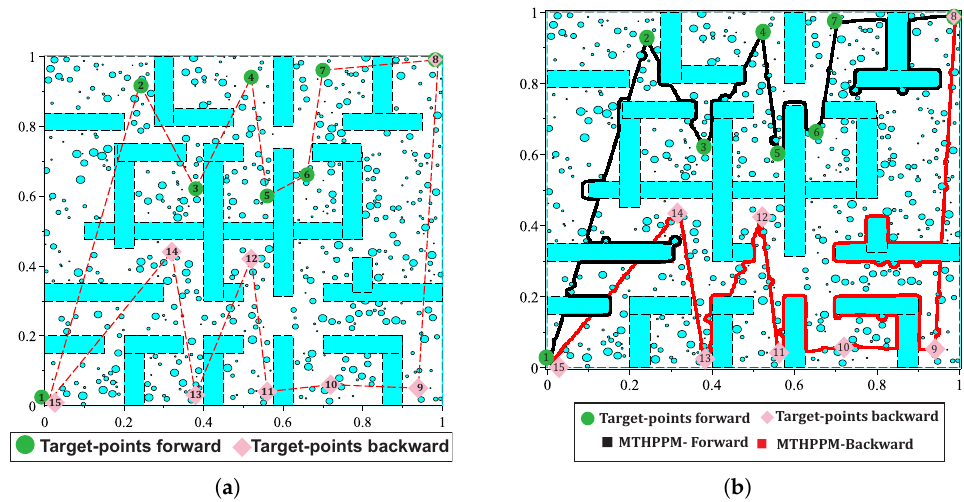
Figure 26. Performance of MTHPPM for office-like environments. ( a ) Piecewise-linear representation of direct path for multiple-target approach. ( b ) Successful solution path.